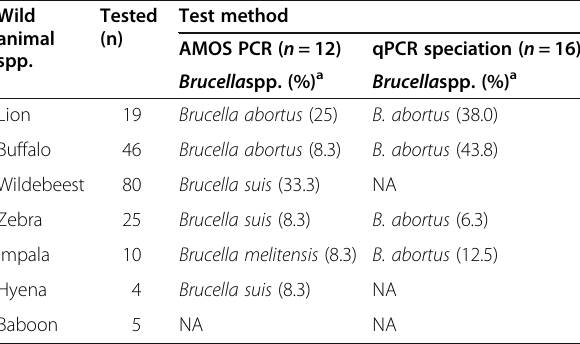
Table 2 Brucella spp. detected by AMOS PCR and qPCR speciation assay in wild animals from the Serengeti ecosystem